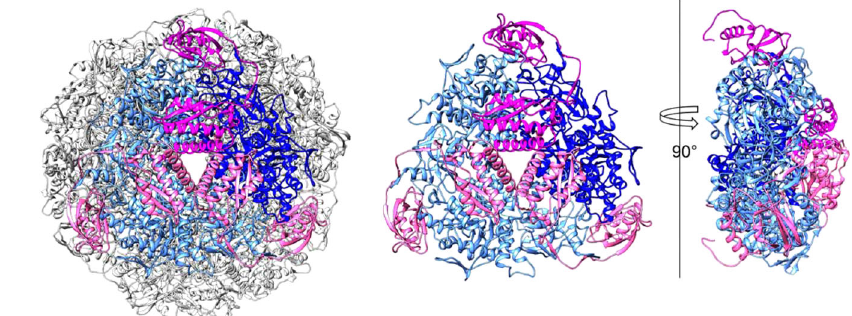
Fig. 2 Cryo-EM model of Helicobacter pylori urease with one trimer highlighted. Dodecamer where one trimer contains three copies of UreA highlighted in shades of pink and three copies of chain UreB highlighted in shades of blue (left). One trimer only using the same coloring scheme (center). Sideview of one trimer rotated 90° around a vertical axis